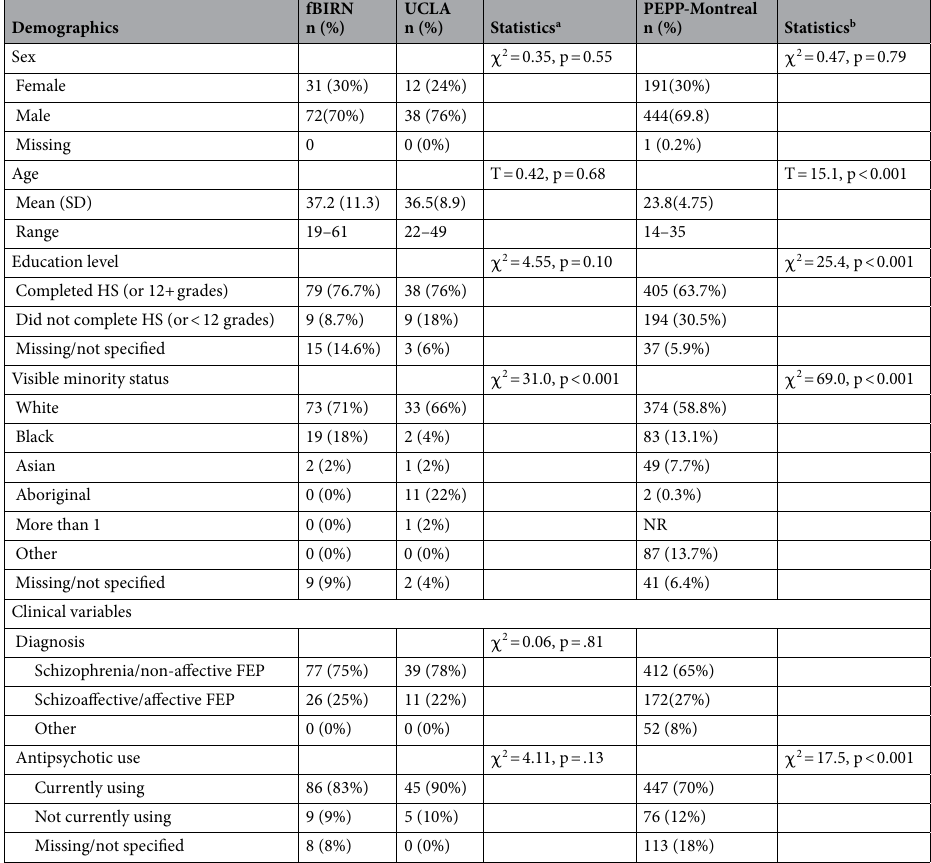
Table 1. Demographic and clinical measures in persistent psychotic illness participants divided by open- access data source (fBIRN or UCLA), as well as the FEP replication sample. a Statistics reported for differences between fBIRN and UCLA persistent psychotic illness samples. b Statistics reported for for differences between MPEPP and other